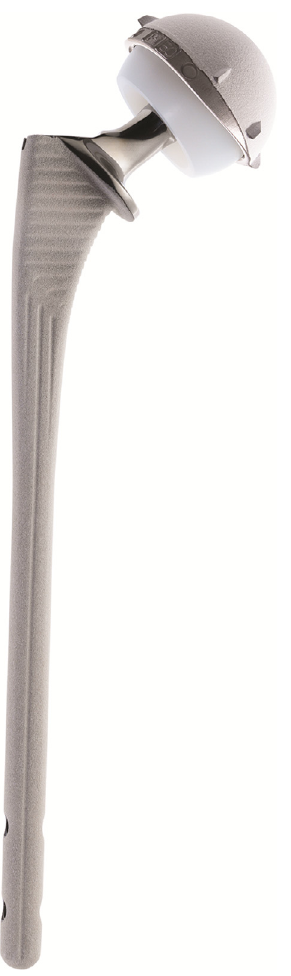
Figure 1. Long cementless stem TARGOS TM and DMC QUAT- TRO TM – groupe Lépine (Genay – France).